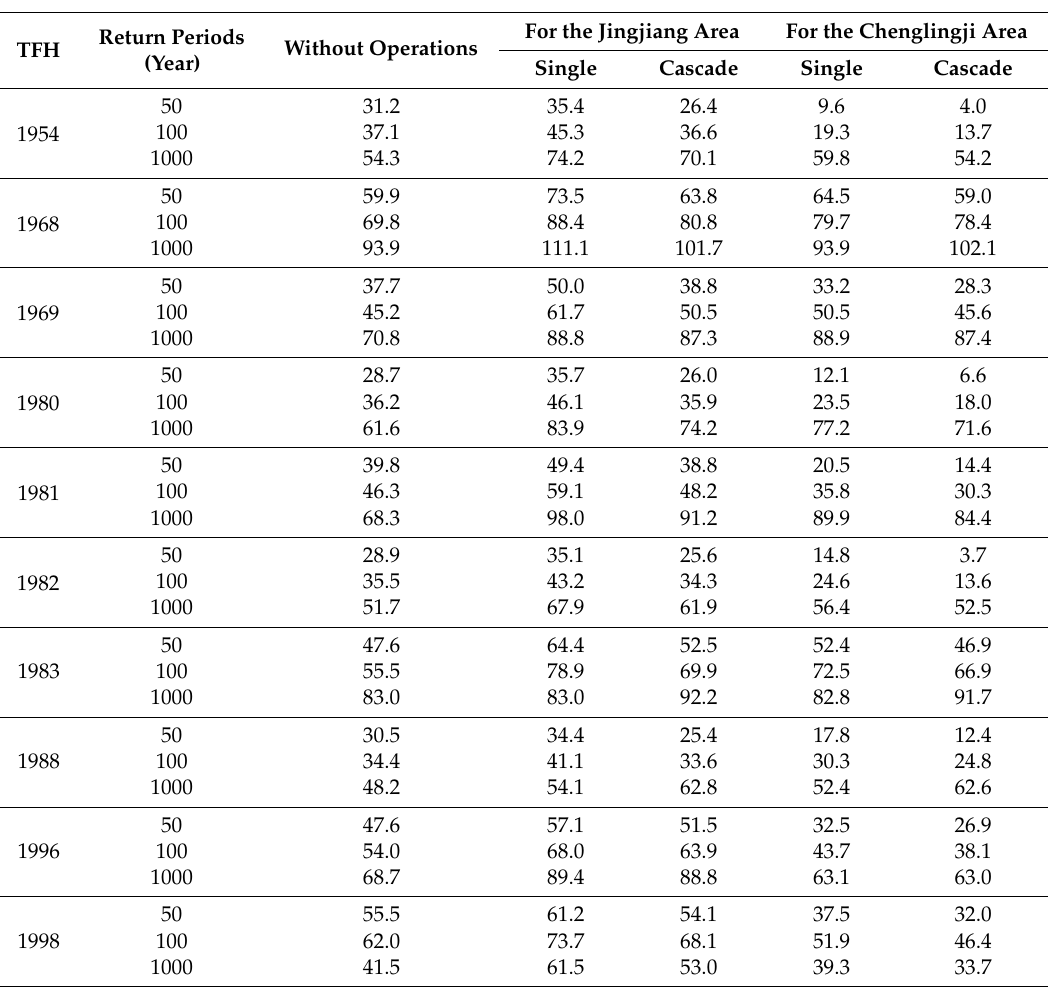
Table 5. Flood diversion volumes of each design flood hydrograph (DFH) at the Chenglingji flood control point (billion m 3